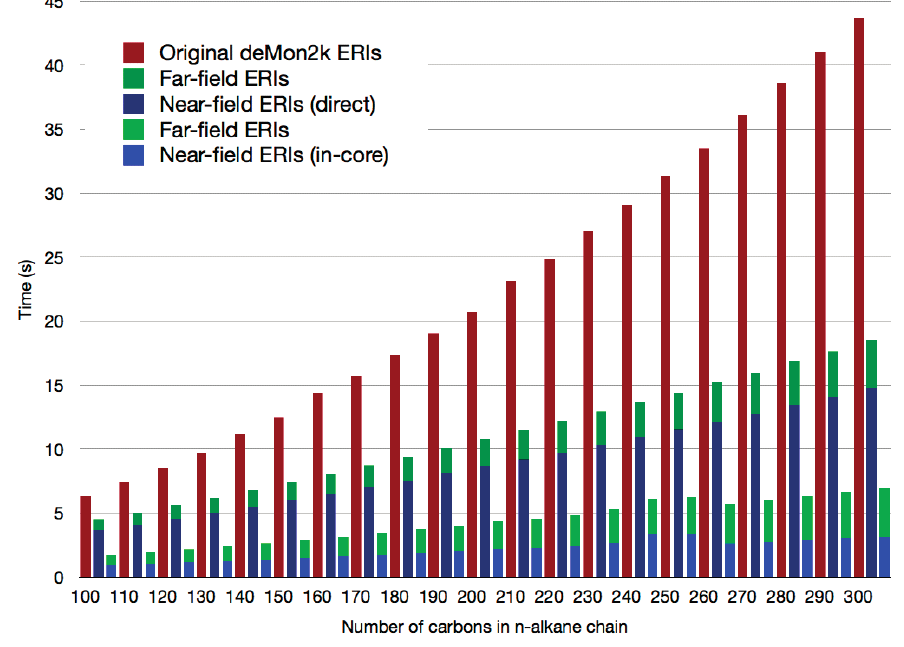
Figure 4. ERI calculation time per SCF cycle for selected n -alkane chains using the original deMon2k code (red bars), the direct SCF scheme with double asymptotic ERI expansion (dark blue and dark green bars) and the mixed SCF scheme (light blue and light green bars). Times refer to parallel runs with 12